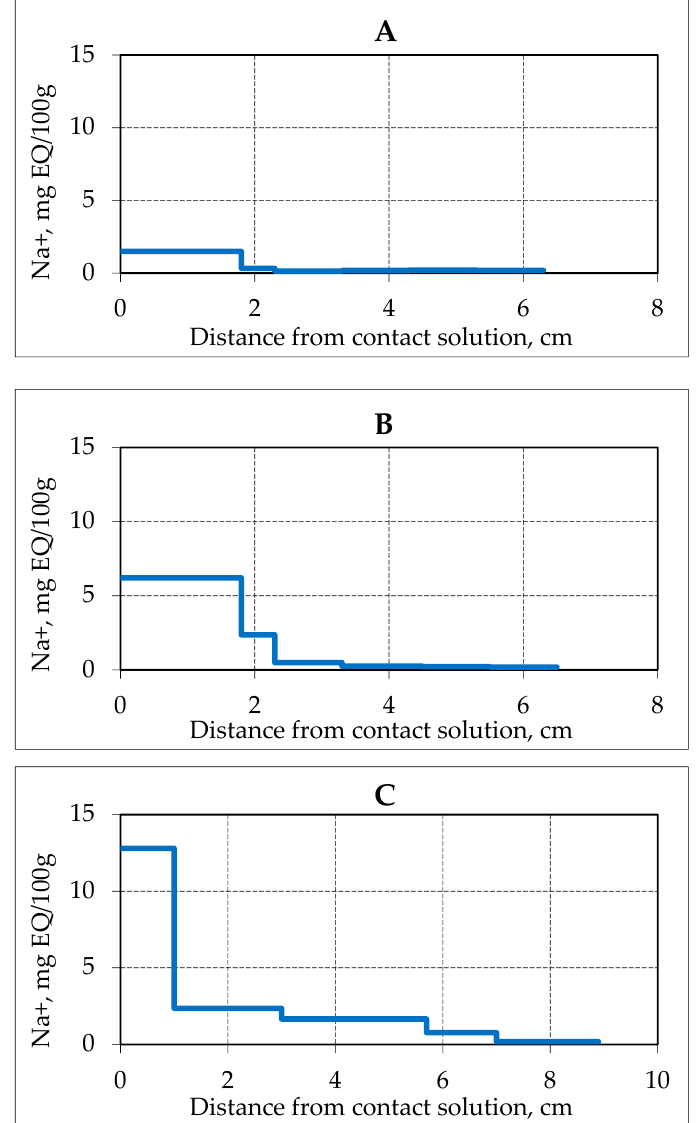
Figure 8. Accumulation of Na + ions in samples of frozen hydrate saturated sand (sand 2, W = 16%) after 3 h of contact with NaCl solution of various concentrations at a temperature of − 3 ◦ C. ( A – C )—solution concentration, respectively, 0.1, 0.2 and 0.4 N.